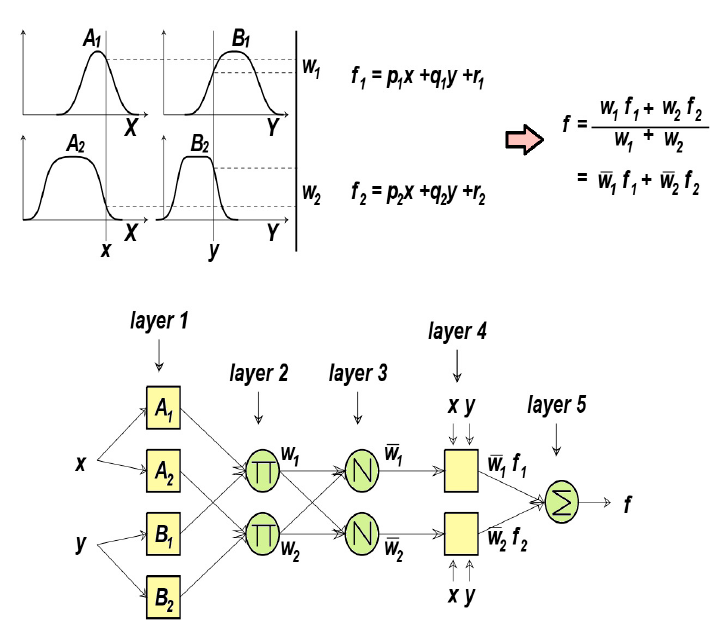
Figure 1. ANFIS Figure 1. ANFIS structure.